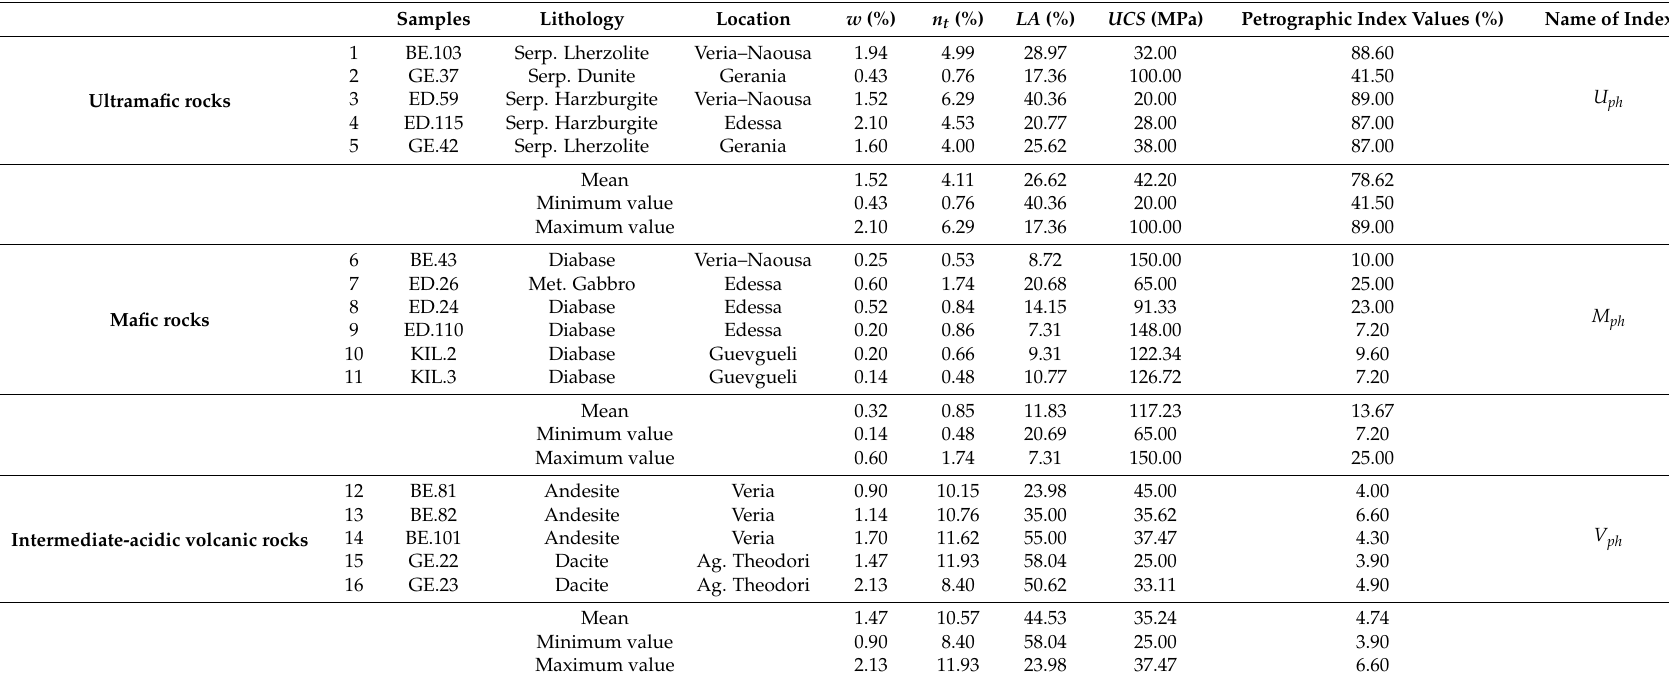
Table 2. Physical and mechanical properties of the tested samples and their minimum, maximum, and mean values as well as their petrographic indexes Samples Lithology